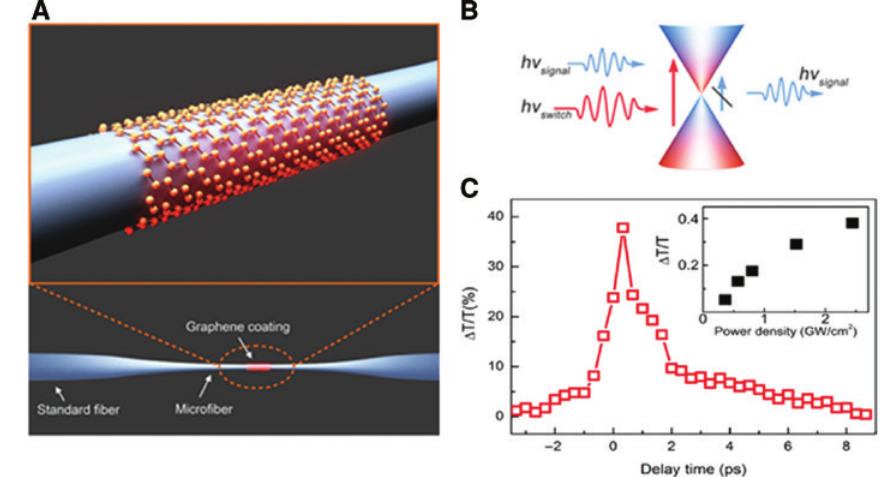
Figure 4: 2D materials-based absorptive modulation with fiber. (A) Schematic illustration of an all-optical modulation scheme based on graphene-clad microfiber. (B) Schematic diagram of the working mechanism of the all-optical modulation based on saturable absorption. (C) The response time measured by pump-probe technique for the modulator, the inset shows the dependence of the modulation depth on pump intensity [132]. (A–C) Reproduced with permission [132]. Copyright 2014, American Chemical